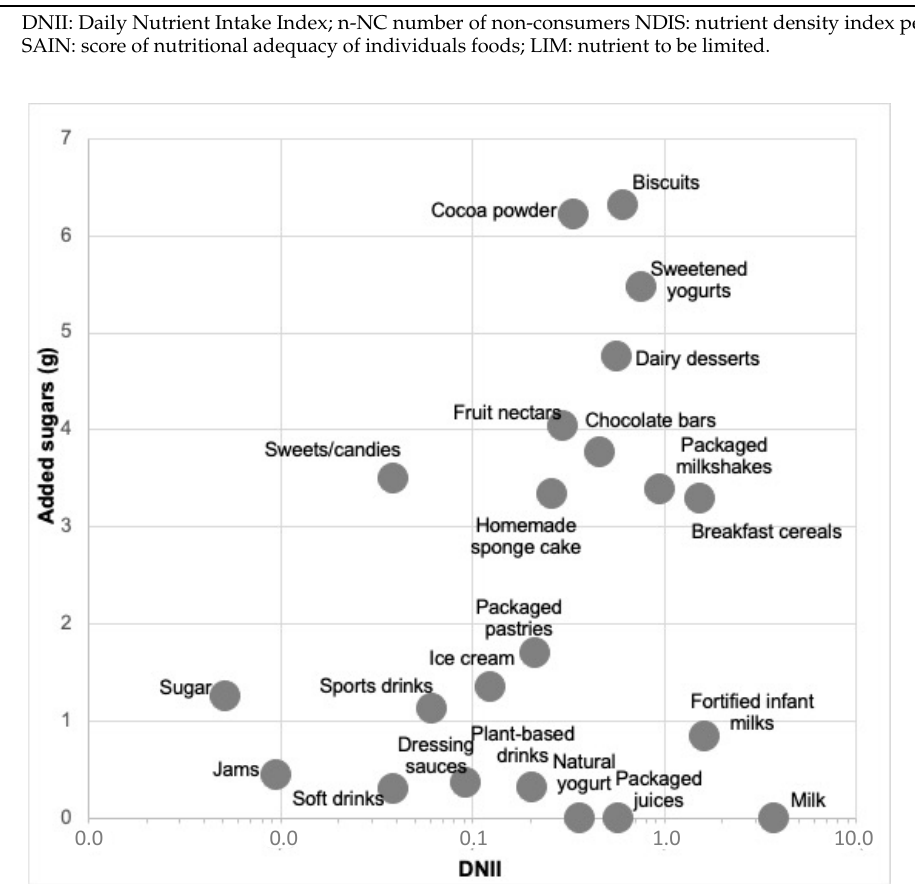
Figure 1 DNII (daily nutrient intake index) vs. added sugars per daily food consumption. Figure 1. DNII (daily nutrient intake index) vs. added sugars per daily food Table 2. Added sugars daily contribution, quality indexes, added sugars, quality perception, and